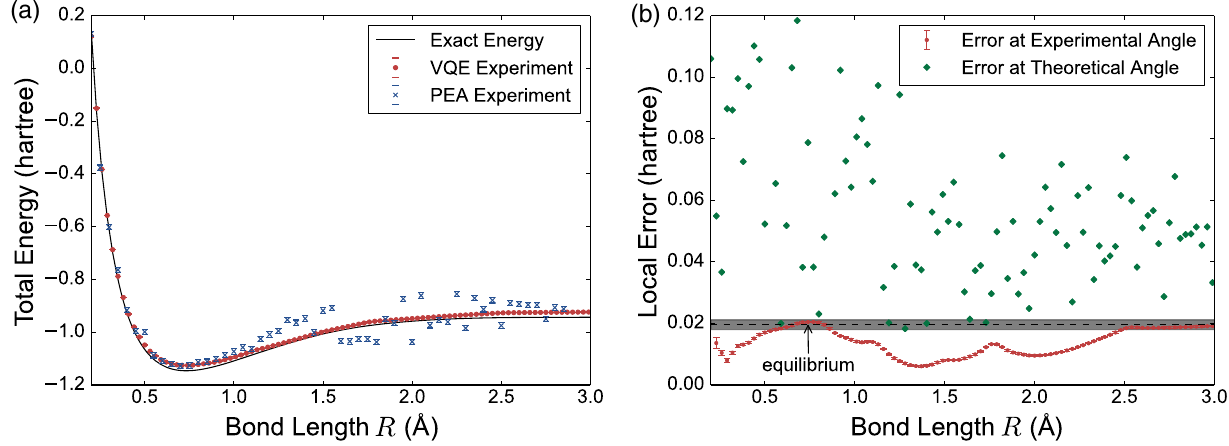
FIG. 3. Computed H 2 energy curve and errors. (a) Energy surface of molecular hydrogen as determined by both VQE and PEA. VQE approach shows dissociation energy error of ð 8 (cid:2) 5 Þ × 10 − 4 hartree (error bars on VQE data are smaller than markers). PEA approach shows dissociation energy error of ð 1 (cid:2) 1 Þ × 10 − 2 hartree. (b) Errors in VQE energy surface. Red dots show error in the experimentally determined energies. Green diamonds show the error in the energies that would have been obtained experimentally by running the circuit at the theoretically optimal θ instead of the experimentally optimal θ . The discrepancy between blue and red dots provides experimental evidence for the robustness of VQE, which could not have been anticipated via numerical simulations. The gray band encloses the chemically accurate region relative to the experimental energy of the atomized molecule. The dissociation energy is relative to the equilibrium geometry, which falls within this